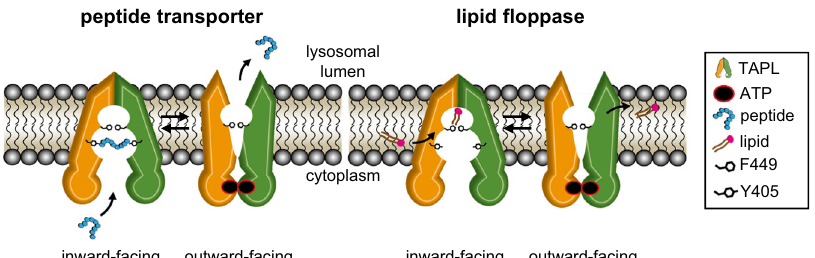
Fig.9|TAPLplaysadualroleasapeptidetransporterandlipid fl oppase.